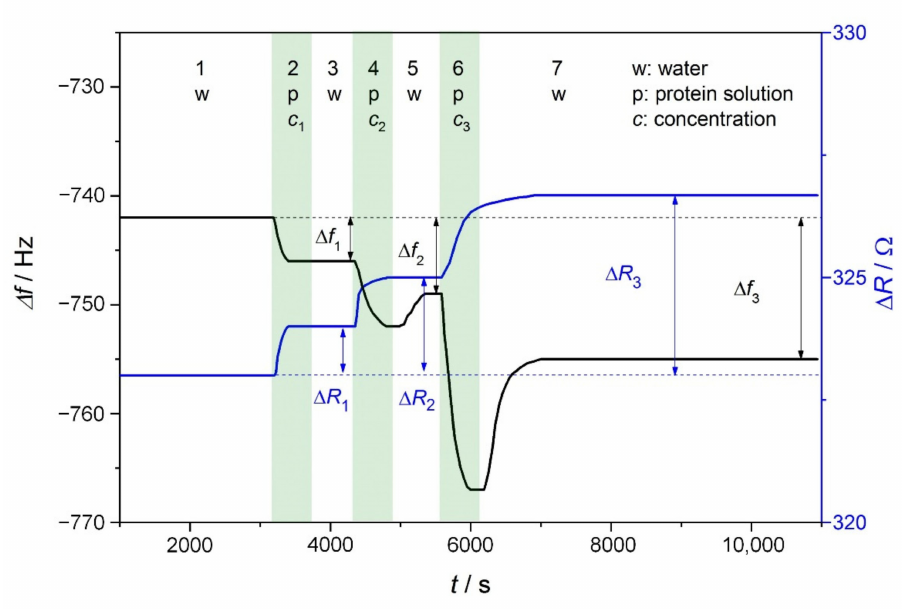
Figure 7. Changes in the resonance frequency ( ∆ f , black line) and resonance resistance ( ∆ R , blue line) of the quartz crystal microbalance (QCM) crystal over time ( t ). Both parameters are 0 for a pure crystal in contact with air. In step 1, the baseline is obtained with water. In steps 2, 4 and 6, protein solutions of increasing concentration are in contact with the crystal ( c 2 = 10 c 1 , c 3 = 100 c 1 ). In steps 3, 5 and 7, the crystal surface is rinsed with water.